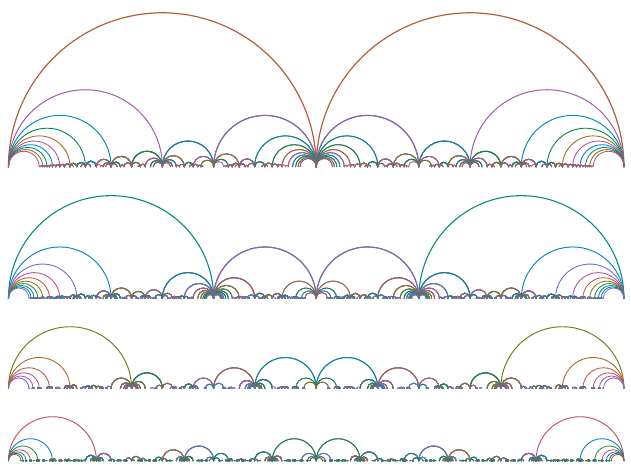
Figure 4. Lines of marginal stability in the R -strip in Z N CHL models with N = 2 , 3 , 5 , 7 from top to